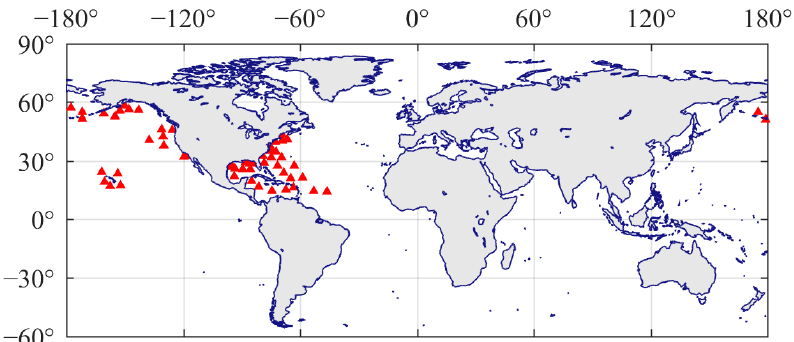
Figure 1. Locations of the collocated buoys.